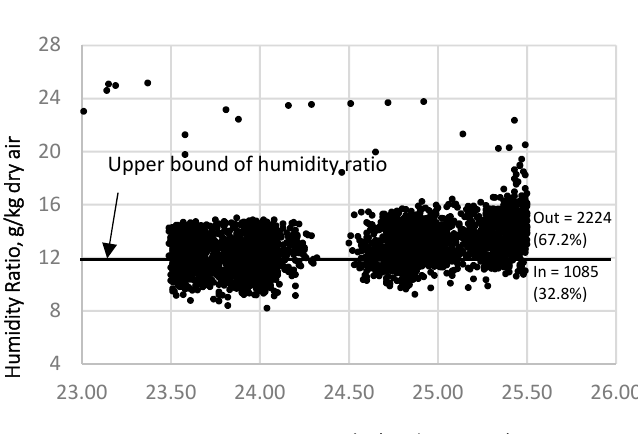
Figure 8. Summary of hourly humidity, temperature conditions for various cities.